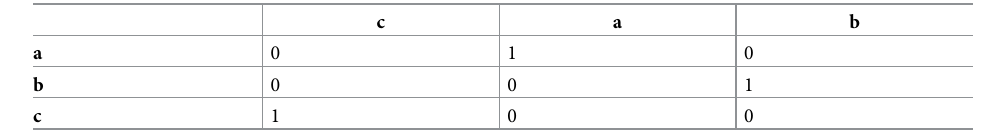
Table 2. Illustration of character